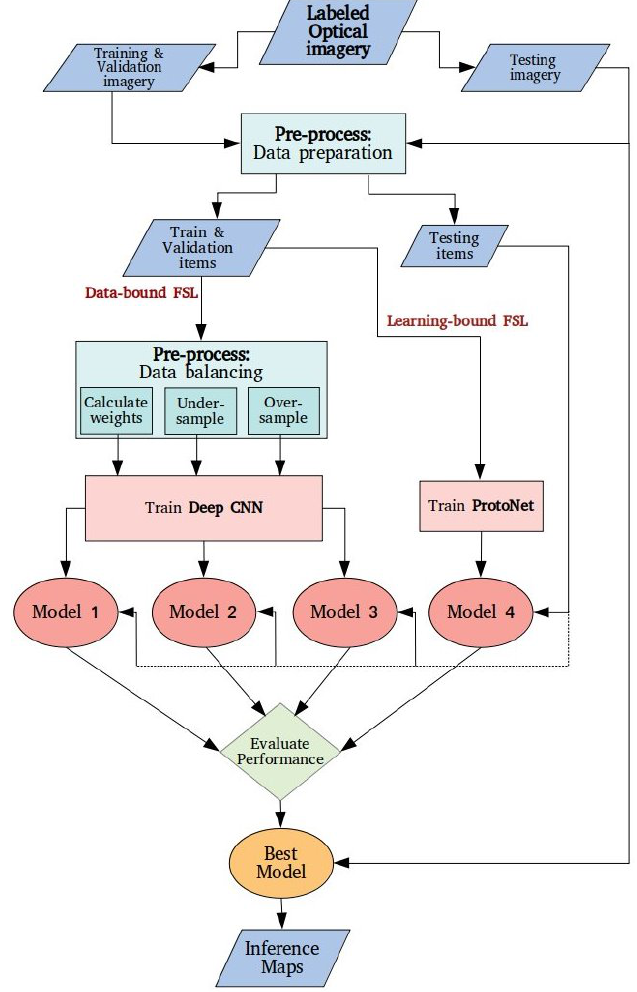
Figure 2. Methodology